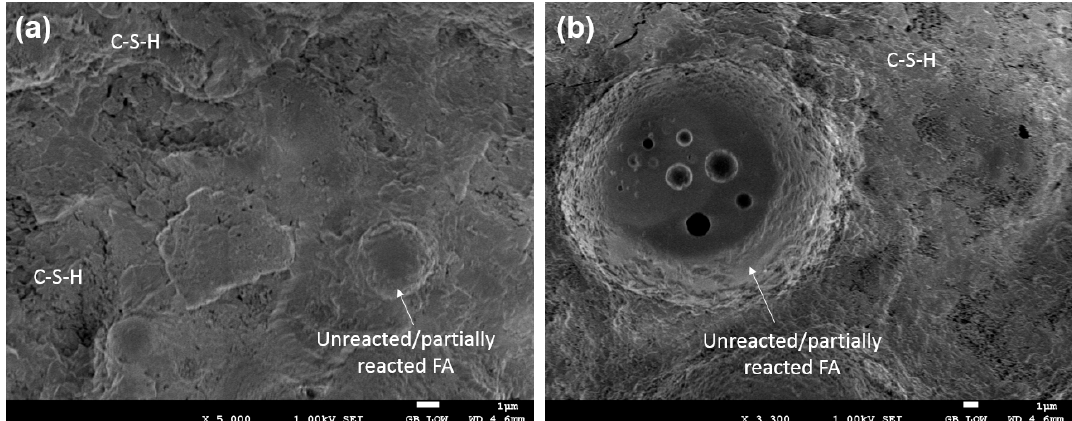
Figure 11. Fe-SEM image of NM mortar at 28 days showing ( a ) unreacted FA particles; ( b ) formation of C-S-H gel.